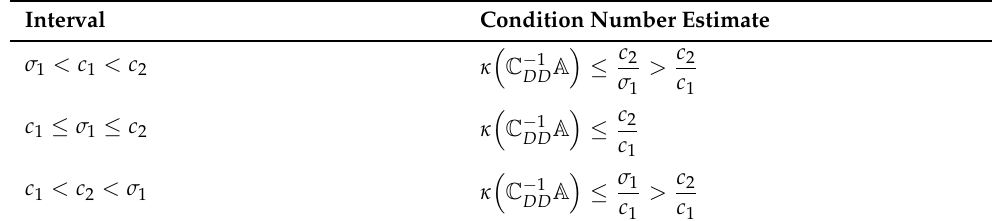
(cid:16) (cid:17) C − 1 A on the scaling parameter σ 1 . DD